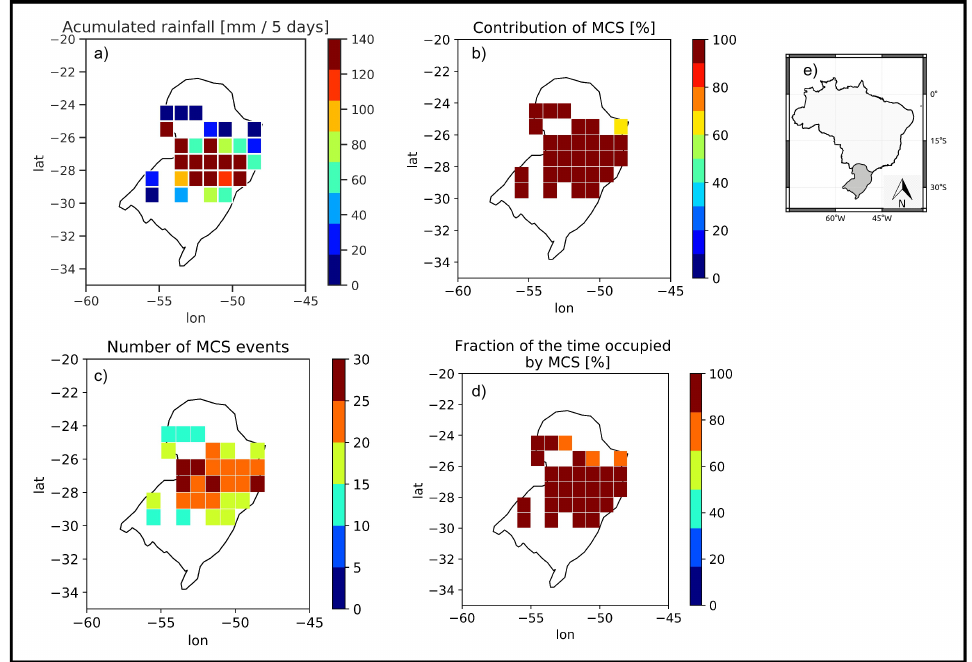
Figure 4. ( a ) Accumulated rainfall recorded from 24 June 2014 to 28 June 2014 in the south region of Brazil (R1); ( b ) fraction of rain on days that had MCS record over the rain accumulated in five days; ( c ) number of MCS events recorded in five days; ( d ) fraction of the days that had MCS records; ( e ) analyzed